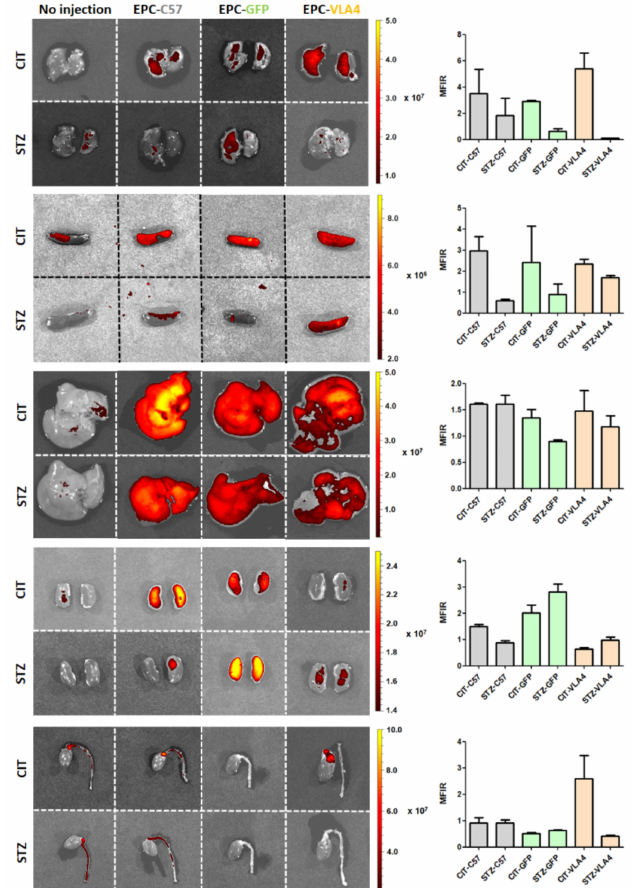
Figure 2. Organ distribution of EPCs. The graphs show the mean from duplicate measurements. Due to the low number of animals used (n = 2 per group), no statistical analyses were